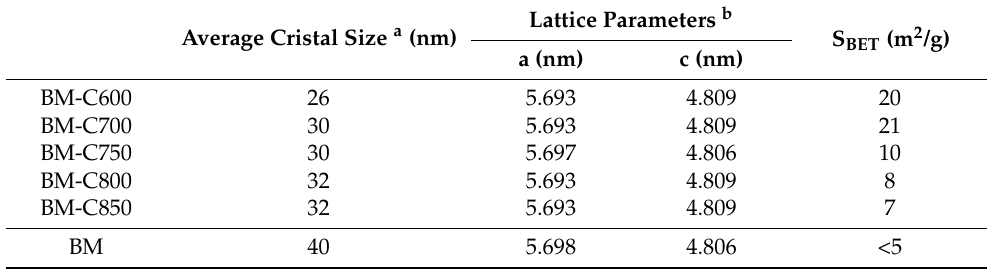
Figure 1. X-ray patterns of BM-CX series and BM as reference. Table 1. Structural, morphological, and textural